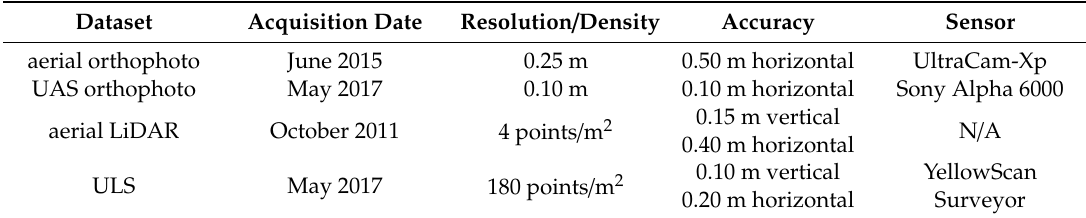
Table 1. Characteristics of the data used in the experiment. UAS: Unmanned Aerial System; ULS: UAS Laser